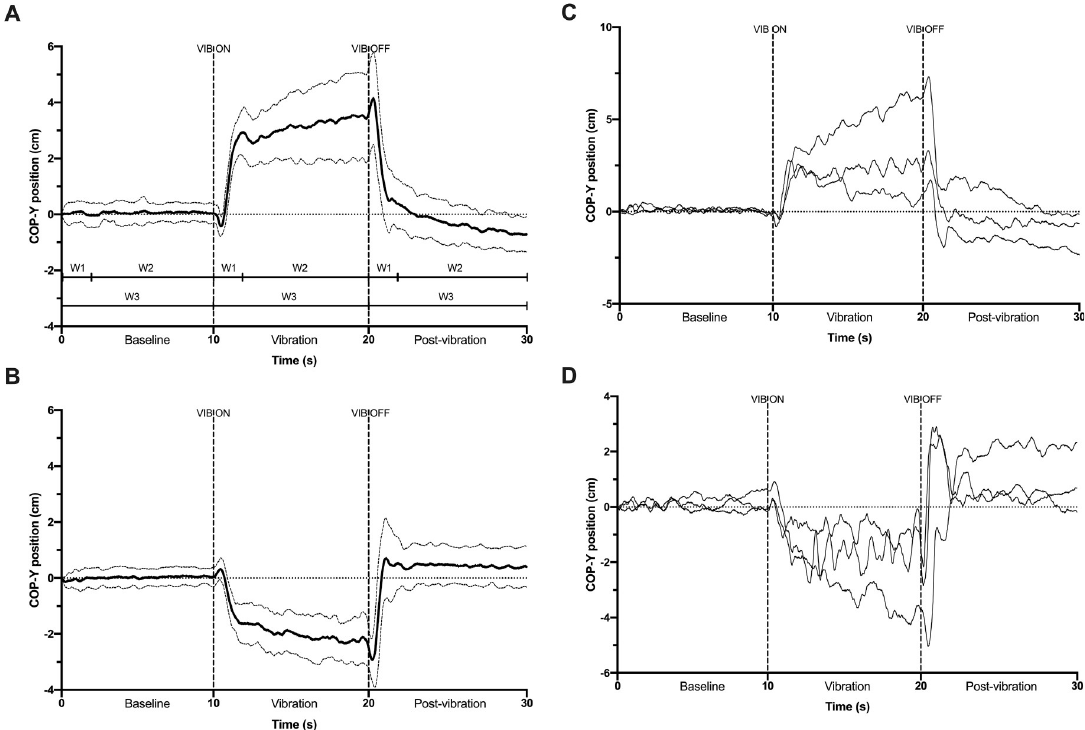
Fig 1. Graphical representation of VIB-PR for TIB (A, C) and ACH (B, D) conditions. Graphs A & B illustrate group mean and standard deviation of COP position in the anteroposterior axis (COP-Y position). Graphs C & D illustrate examples of mean individual VIB-PR traces (i.e. their mean trace from the five trials) from three participants presenting with distinctive patterns. VIB = vibration; W1 = the First 2 s time-window; W2 = the Last 8 s time-window; W3 = the Whole 10 s time-window.